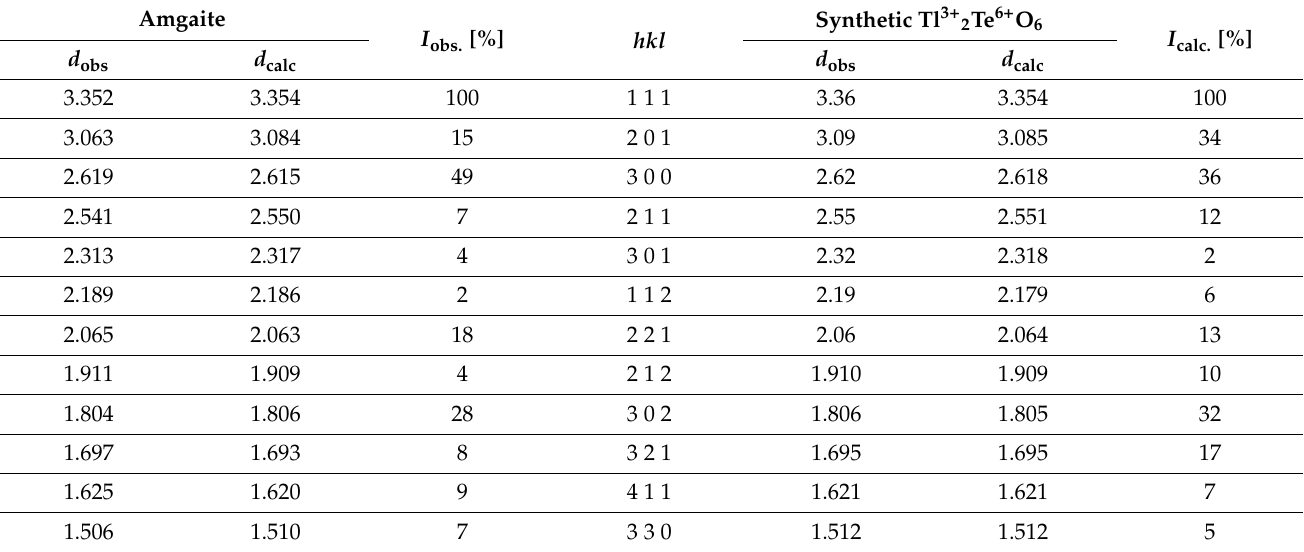
Synthetic Tl 3+ 2 Te 6+ O